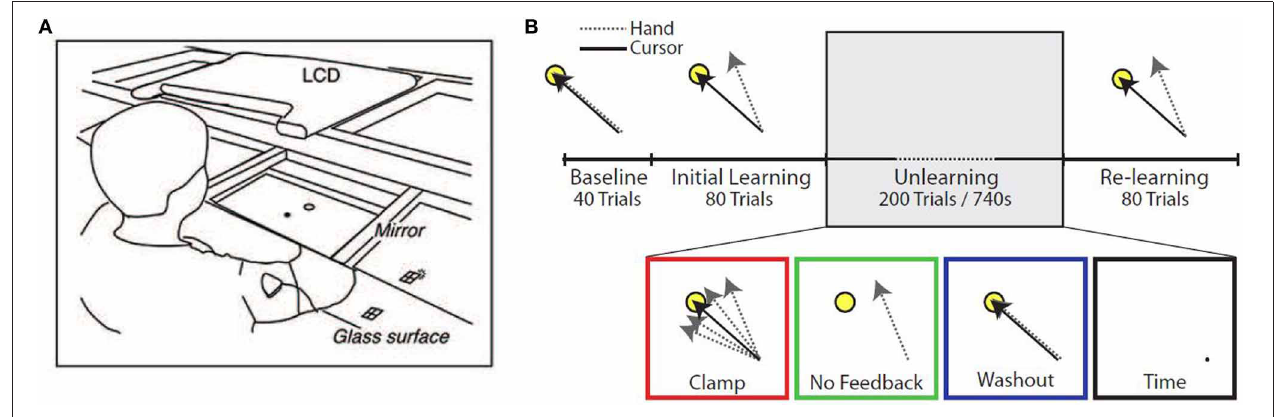
FIGURE 1 | Experimental setup. (A) Diagram of experimental apparatus. (B) Experimental protocol. Subjects performed up to 400 trials in a single block, divided into four epochs: Baseline (veridical feedback), Initial Learning (30 ◦ counterclockwise rotation), Unlearning , and Re-learning (30 ◦